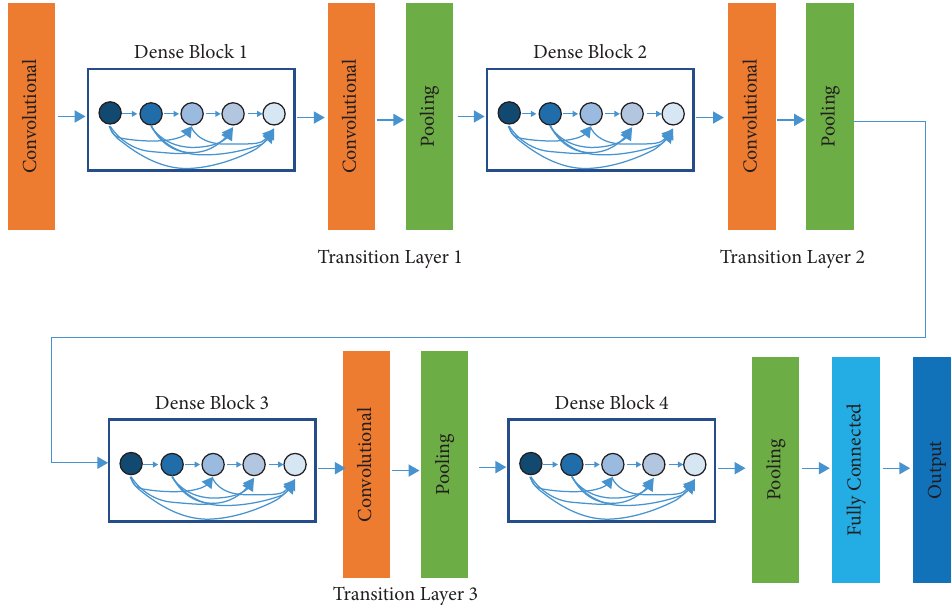
Figure 6: DenseNet201 architecture.